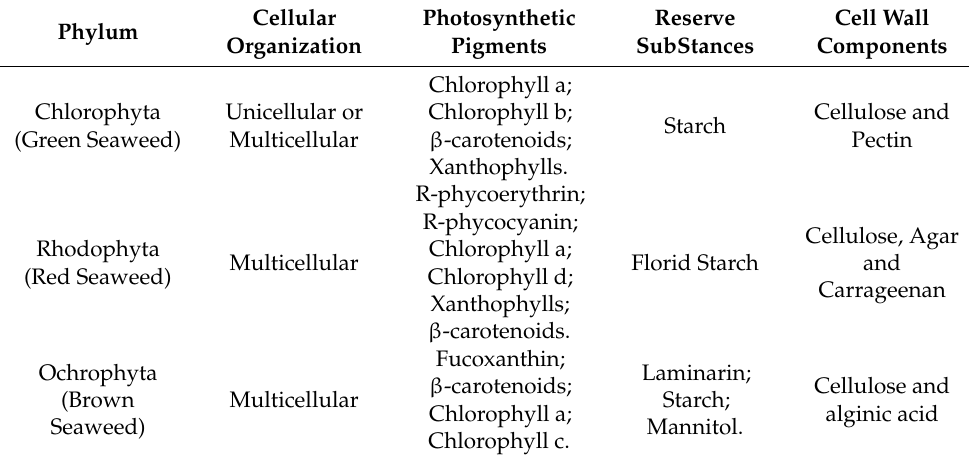
Reserve Cell Wall SubStances Components Cellulose and Starch Pectin Cellulose, Agar Florid Starch and Carrageenan Laminarin; Cellulose and Starch; alginic Mannitol.